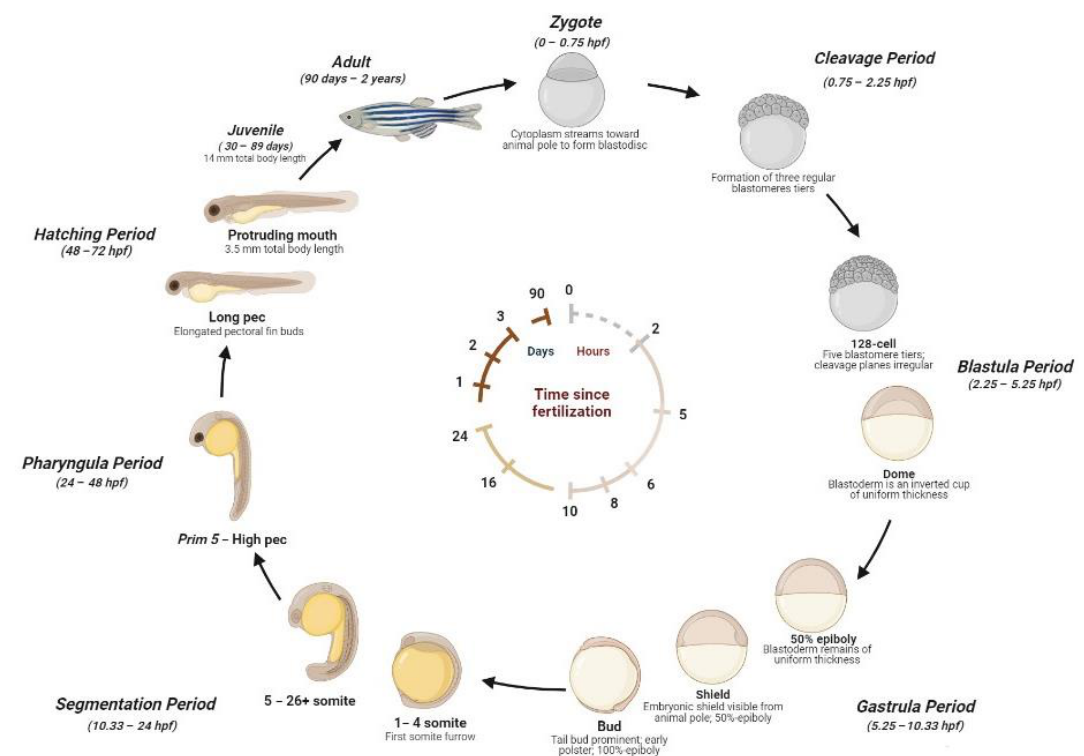
Figure 1. Zebrafish development stages. Zygote (1k-cell stage) (0–0.75 hpf): the newly fertilized egg until the first cleavage occurs (after 40 min). Cleavage Period (0.75–2.25 hpf): the formation of three